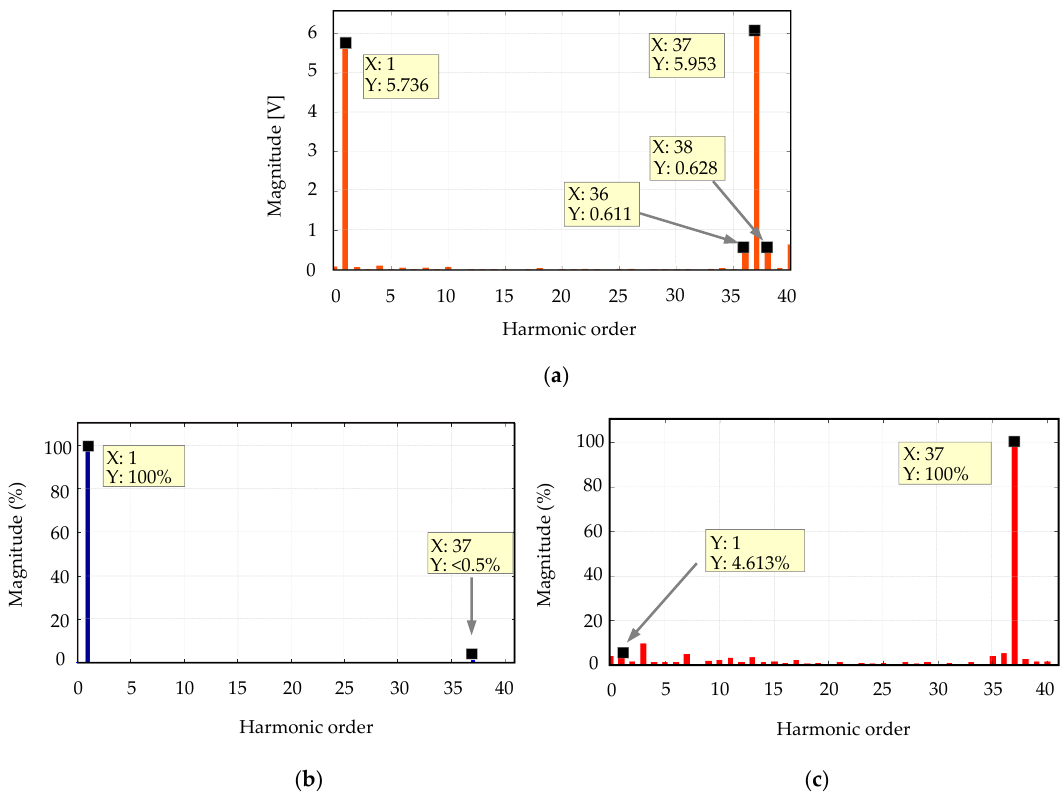
Figure 10. Spectrums of ( a ) V ab , ( b ) V ac 1 , and ( c ) V ac 2 .